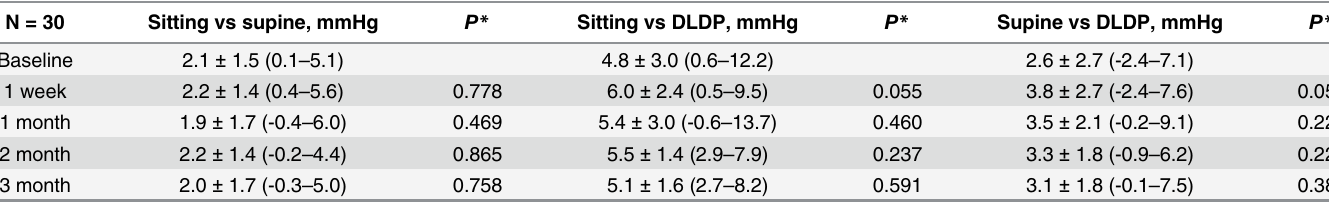
Table 3. The Intraocular Pressure Differences Between Body